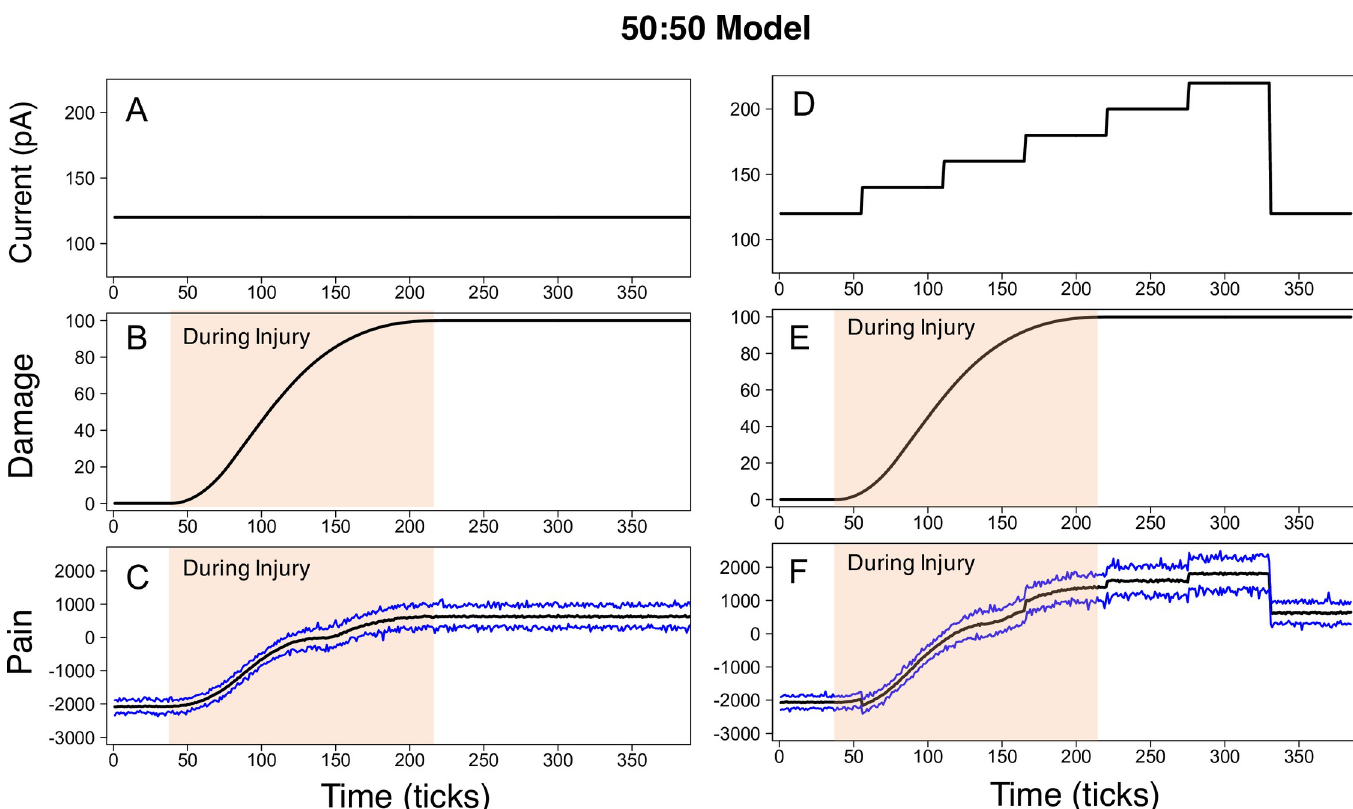
Fig 3. 50:50 model output during constant and ramping current scenarios. The 50:50 model was simulated using constant 120 pA current ( A ) and ramping current ( D ). In the model, PKC δ and SOM neurons accumulate damage during injury. Average damage values from all PKC δ and SOM neurons during the constant current ( B ) and ramping current ( E ) scenarios are displayed. In both scenarios, pain increases during injury and remains elevated post-injury. The average (black line), minimum (bottom blue line), and maximum (top blue line) model pain output across 100 replicate simulations is displayed for the constant current ( C ) and ramping current ( F ) scenarios.